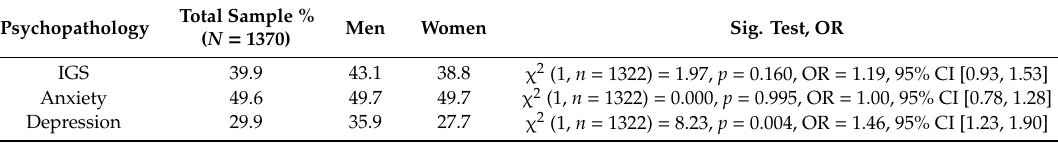
Table 4. Prevalence of psychopathology by